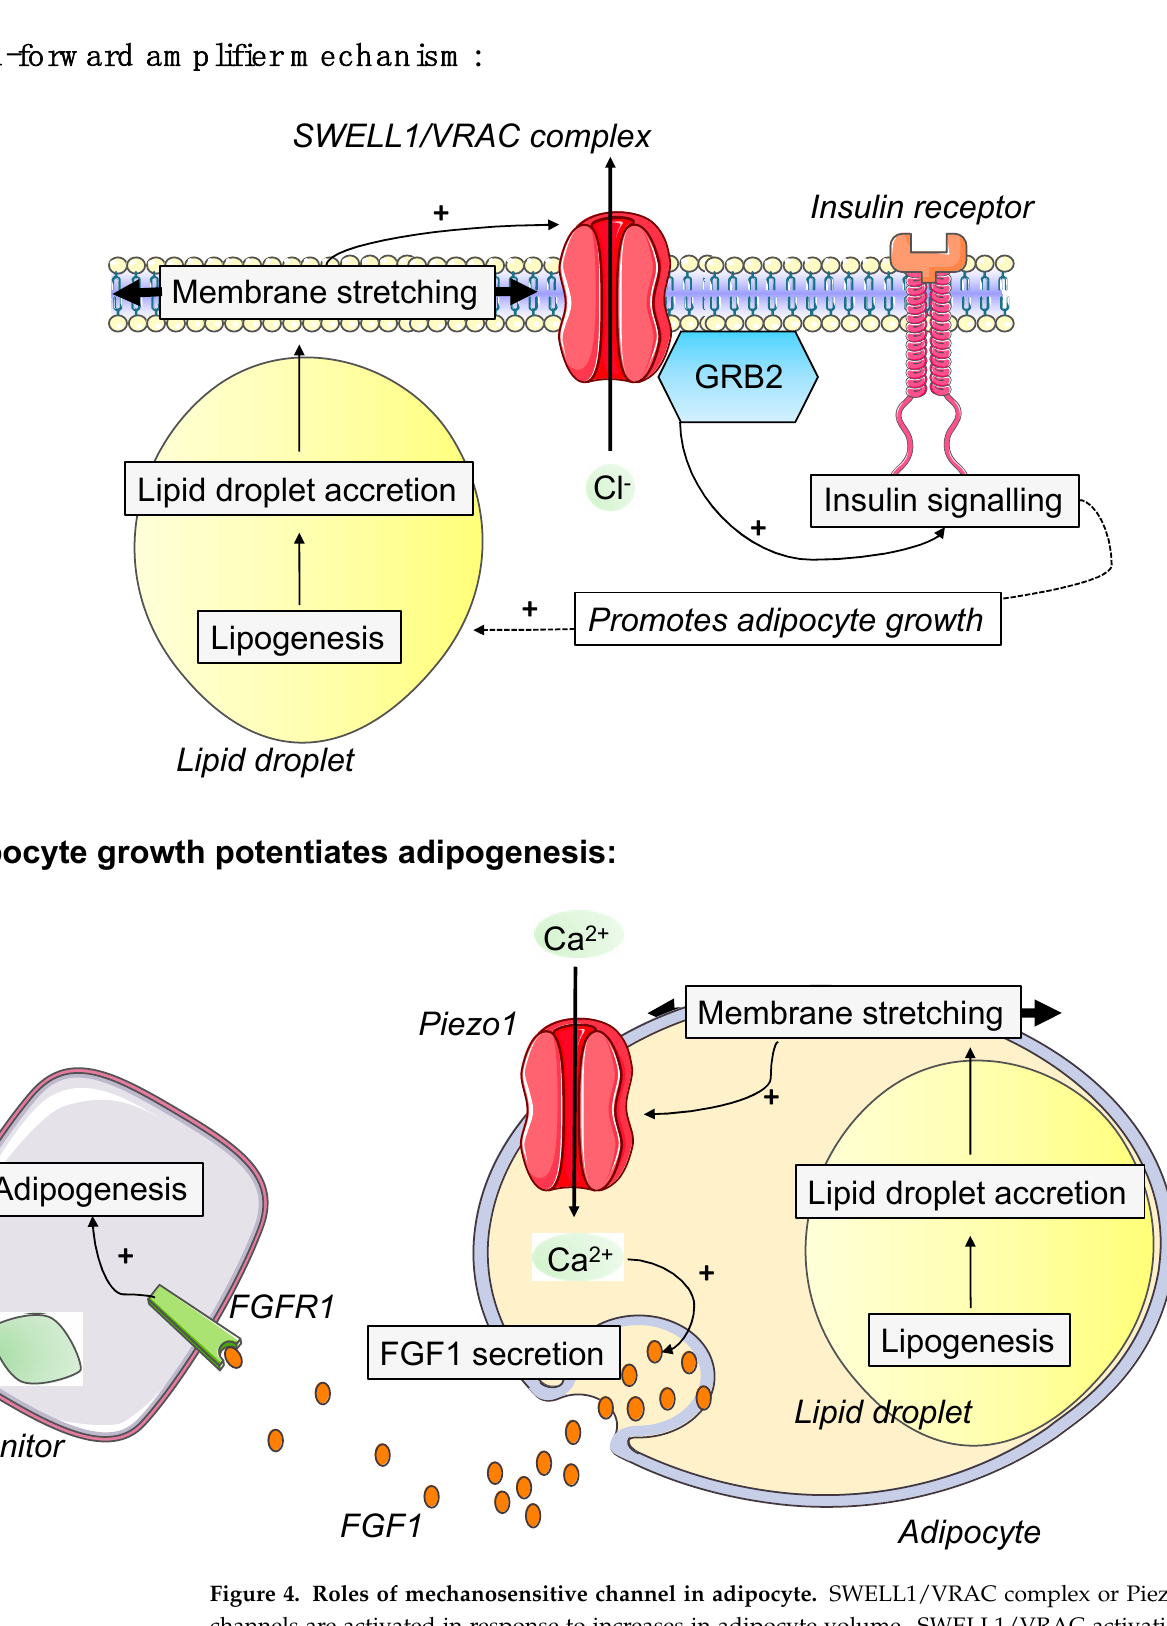
Figure 4. Roles of mechanosensitive channel in adipocyte. SWELL1/VRAC complex or Piezo1 channels are activated in response to increases in adipocyte volume. SWELL1/VRAC activation stimulates insulin–PI3K–AKT2 via GRB2, and thereby supports lipogenesis and continued adipocyte growth in a feed-forward manner [242] However, opening of Piezo1 in mature adipocytes causes the release of the adipogenic fibroblast growth factor 1 (FGF1), which induces adipogenesis through activation of the FGF-receptor-1